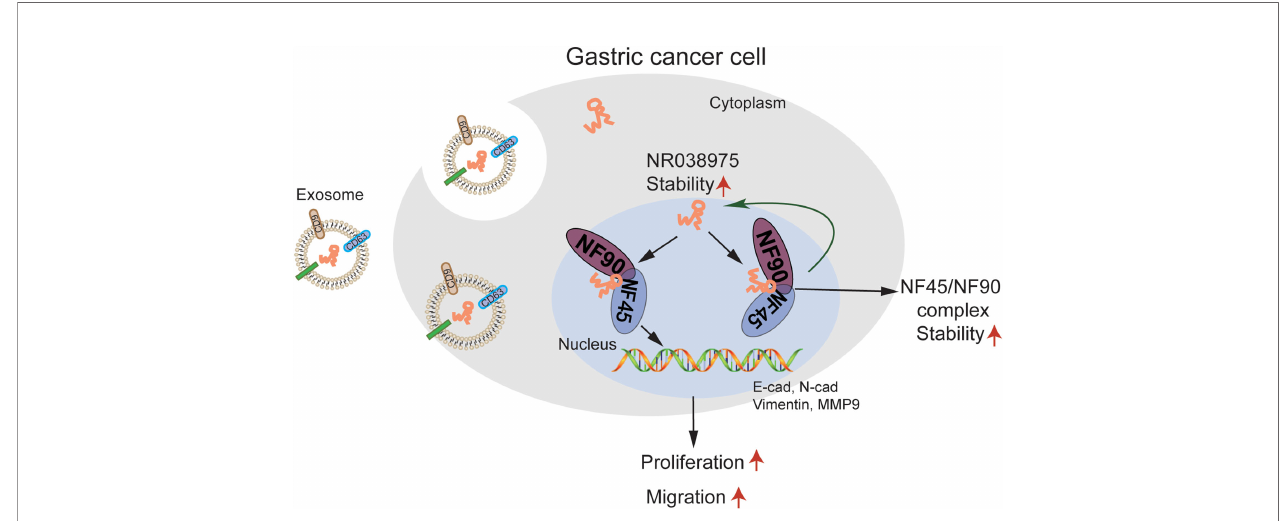
FIGURE 8 | A schematic model of long noncoding RNA (lncRNA) NR038975 functions in gastric carcinogenesis. NR038975 directly binds to NF45 and NF90, which not only increases the stability of NR038975 but also increases the stability of NF45/NF90 complex, so as to promote gastric cancer proliferation and migration. Moreover, NR038975 could be secreted to serum exosome as a diagnostic